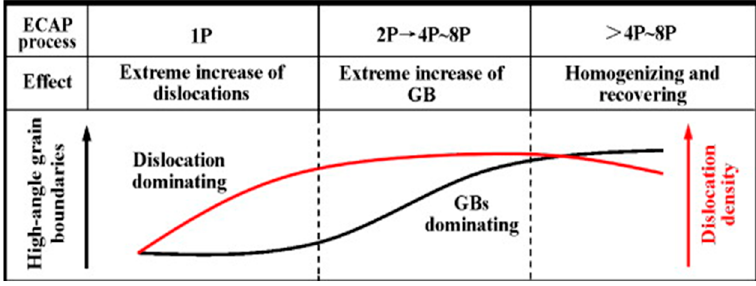
Figure 17. Variation trends of angular grain boundaries and dislocations in copper and its alloys [97]. Reproduced with permission from Elsevier B.V.